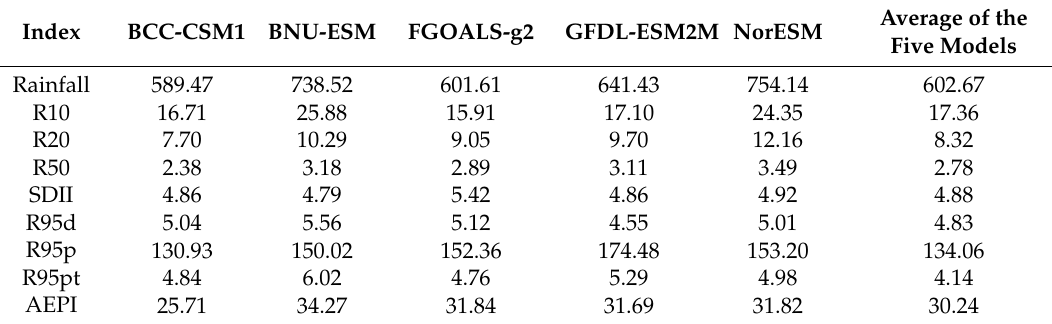
Table A2. RMSE of extreme precipitation indices between CMIP5 models and CMA observations.